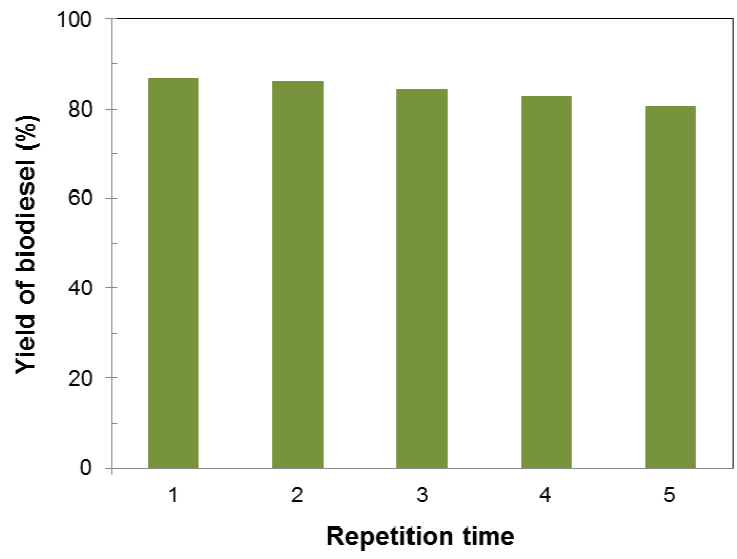
Figure 8. Effect of repetition time on the yield of biodiesel in PBR.